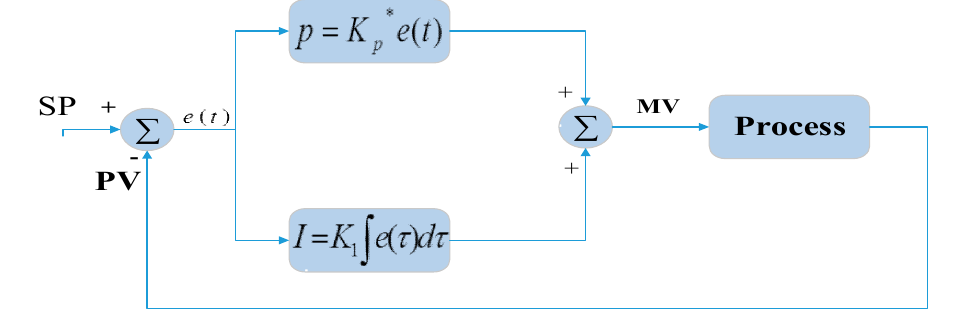
Figure 3. Block Diagram of PI Controller.